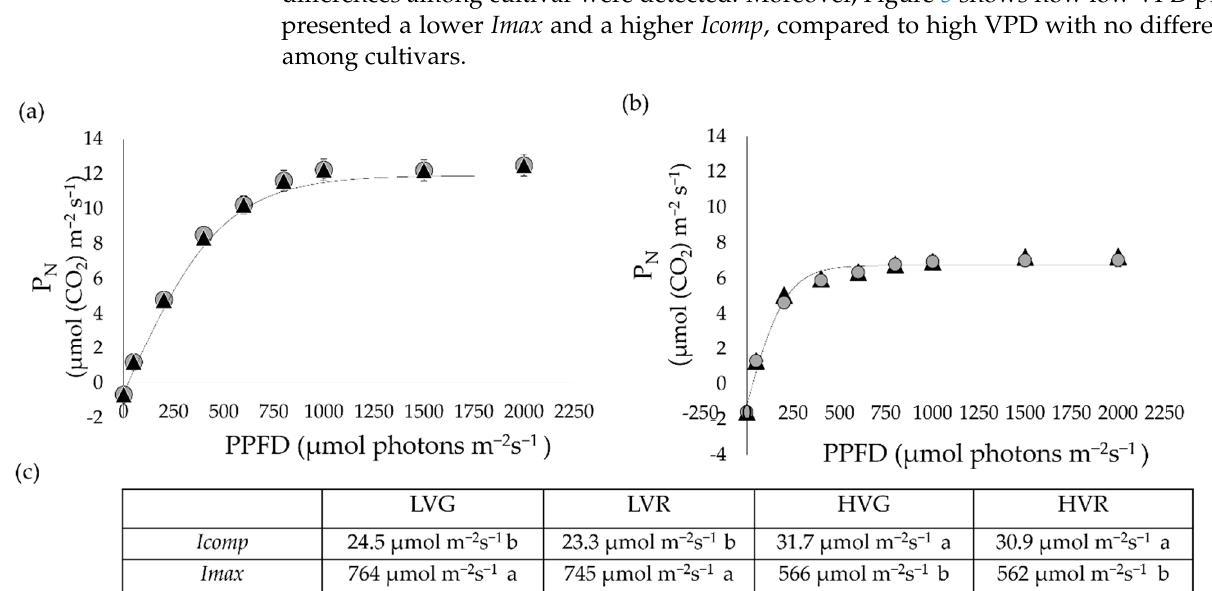
Figure 5. Effect of VPD (LV and HV) on green (G) and red (R) lettuce photosynthetic light curves: ( a ) LVG (black triangles) and LVR (gray circles); ( b ) HVG (black triangles) and HVR (grey circles) and ( c ) derived parameters ( I comp, I max, c), according to the model by Lobo et al. [33]. Mean values (n = 9) ± standard errors are shown. Different letters correspond to significantly different values among treatments within a given date, according to Tukey’s HSD ( p ≤ 0.05).